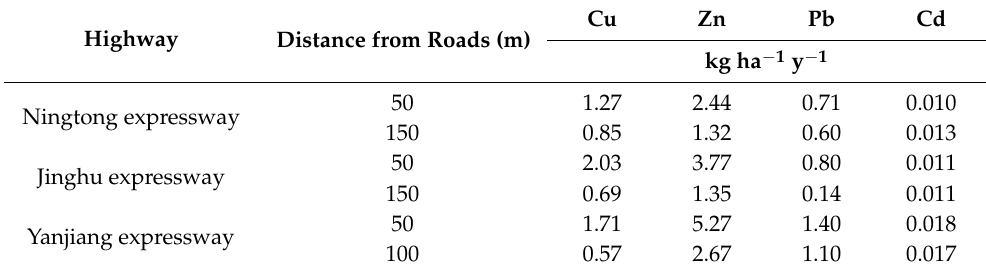
Table 7. Accumulation rates of heavy metals in soil profiles in vicinity of expressways. Cu Zn Pb Cd Highway Distance from Roads (m) kg ha − 1 y − 1 50 1.27 Ningtong expressway 150 0.85 1.32 0.013 Jinghu